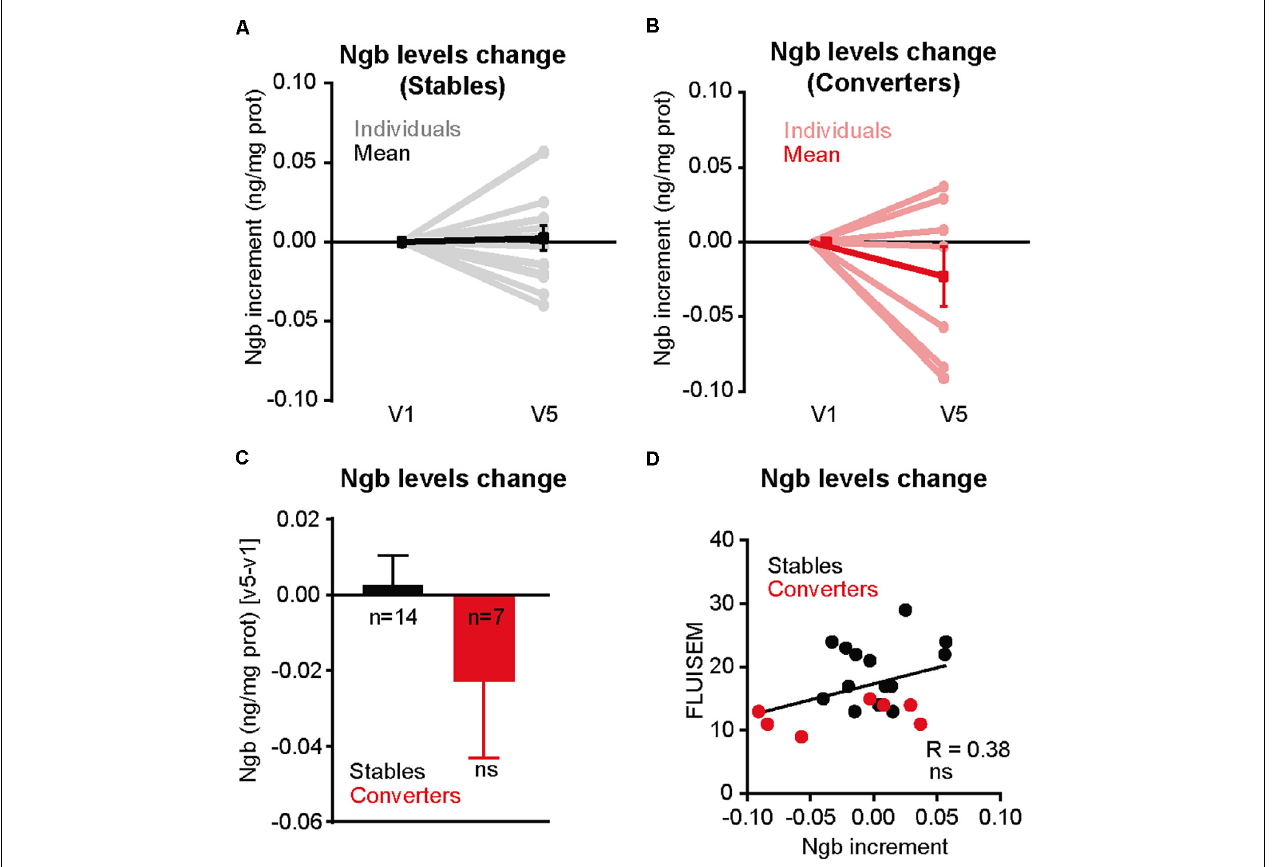
FIGURE 6 | Cognitively altered patients show a decrease in Ngb plasma levels. (A) Representation of the differences in the levels of plasma neuroglobin, normalized by total protein, calculated from the blood of individuals ( n = 14) extracted in the first visit (V1) and the fifth visit, 5 years later (V5), and who did not show a cognitive decline between V5 and V1 determined by several neurological and neuropsychological tests (Stable). The plasma Ngb levels obtained at V1 was set at 0 for comparative purposes. (B) Same representation as in A, but for individuals with signs of mild cognitive impairment (MCI) at V5 versus V1 (Converters). (C) Bar plot illustrating the differences in Ngb levels (normalized by total plasma proteins) between V5 versus V1, for Stable ( n = 14) and Converters ( n = 7) Individuals. Negative values indicate a decrease in absolute Ngb levels between V1 and V5. (D) Correlation between the amount of Ngb levels change (V5 versus V1) and the score obtained by the neuropsychological semantic fluency test FLUIsem. Subjects who score less than 15 in this test are considered to have mild dementia. Negative values in the X axis indicates a decrease in absolute Ngb levels between V1 and